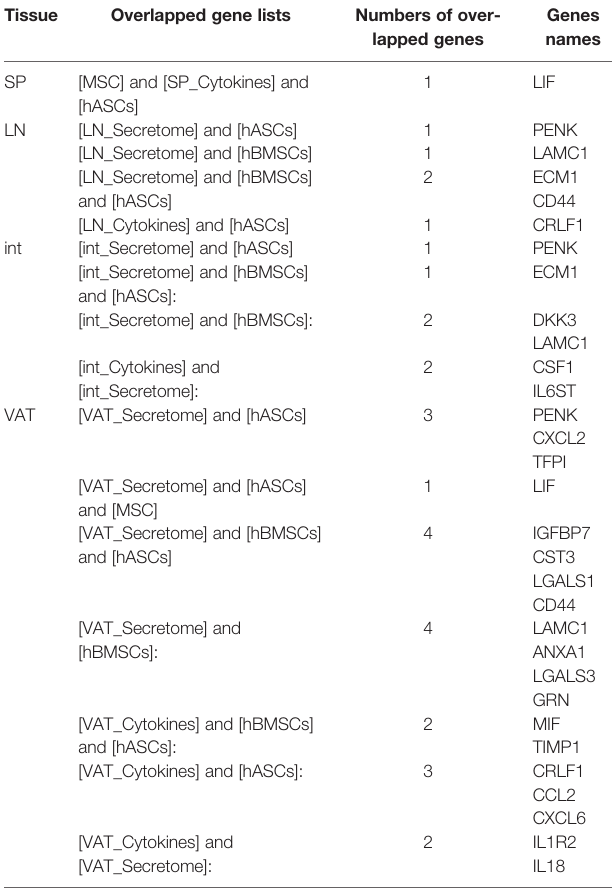
TABLE 12 | The cytokines and secretomic genes shared between four tissue Treg (SP, LN, int, VAT) and four types of stem cells were summarized (hESCs_PMID: 22984290, hBMSCs_PMID: 22674502, hASCs_PMID: 20184379, and MSCs_PMID: 23685070). Tissue